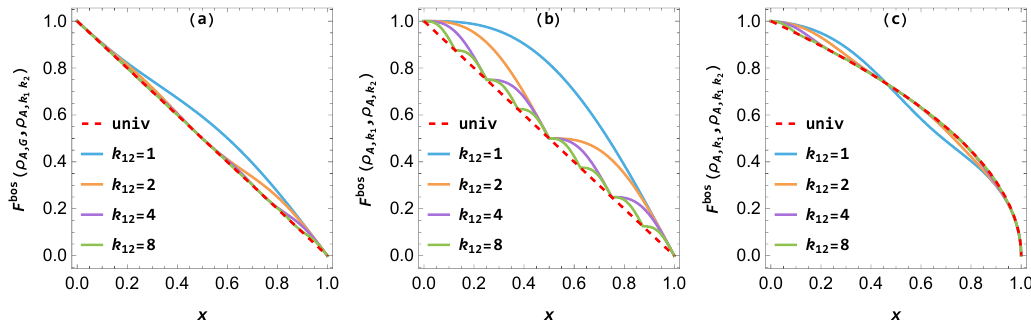
Figure 6 . The fidelities (5.45), (5.46) and (5.47) (solid lines) and their corresponding universal fidelities (3.76), (3.78) and (3.80) (red dotted lines) in the free bosonic chain. We have set L = + ∞